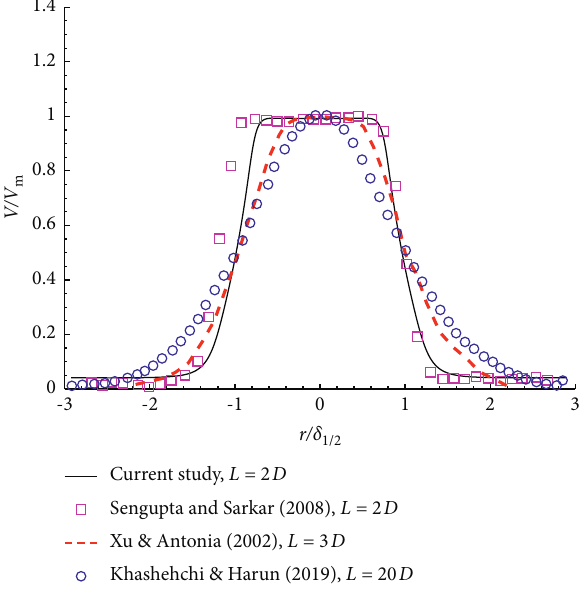
Figure 4: Comparison of normalized axial velocity results of the plane wall jet are in good agreement with the vertical profile suggested by Wood et al. [7] and the results obtained by Eriksson et al. [17] for the outer region ( y > y